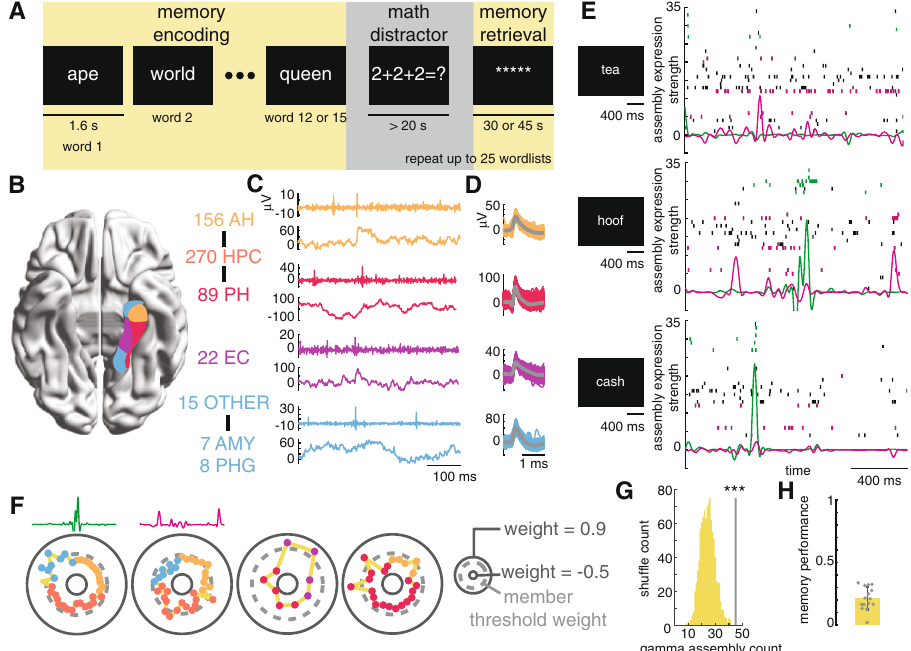
Fig.1|Signi fi cantneuronalassemblyidenti fi cationduringanepisodicmemory task. A Schematic of the free recall task. Each displayed word the participant studiesrepresentsan “ encoding event. ” B Unityield foreachbrainregionincluded in the study. C Example denoised high-frequency signals from which we isolated unit activity (top rows) and local fi eld potentials (bottom rows) for each brain region. Coloring follows the convention shown in ( B ). Numbers next to the region indicatethenumberofunitsisolatedfromeachregionandincludeneuronsfromall sessions ( n =307), not only those from which assemblies were identi fi ed ( n =203). D Example units from each of the high-frequency signals displayed in ( C ). E Expression strength of two example assemblies superimposed on the pertinent spike rasters for three example encoding events. Expression strength curves and